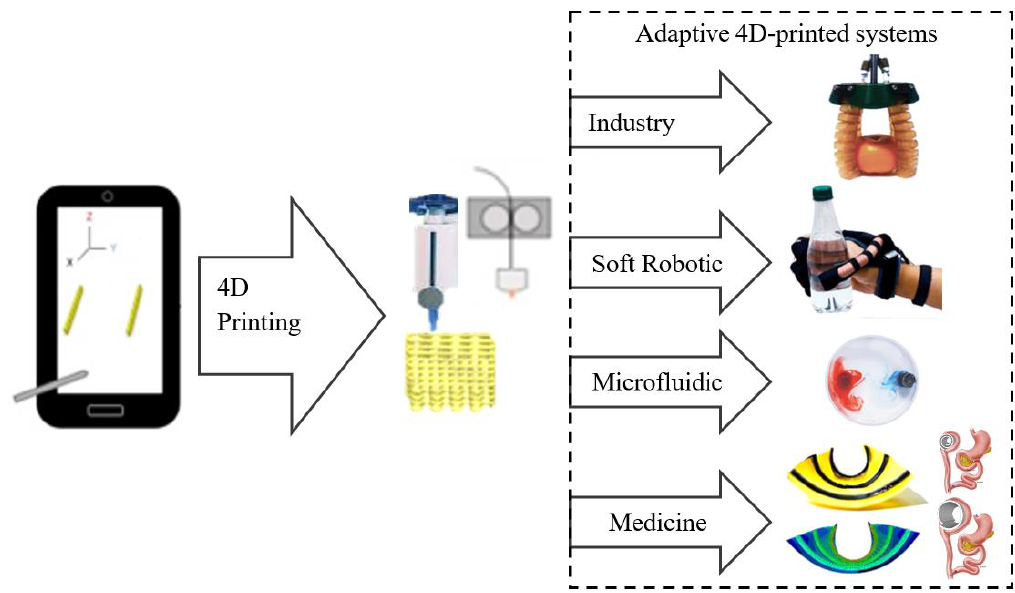
Figure 1. Some applications of the adaptive four-dimensional (4D)-printed systems. The images from top right to bottom are reproduced from [29] with the permission of the MDPI, [30] with the permission of the RMIT University Research Repository; Reproduced with permission from [31], Copyright Elsevier, 2015 ; [32] with the permission of the MDPI.